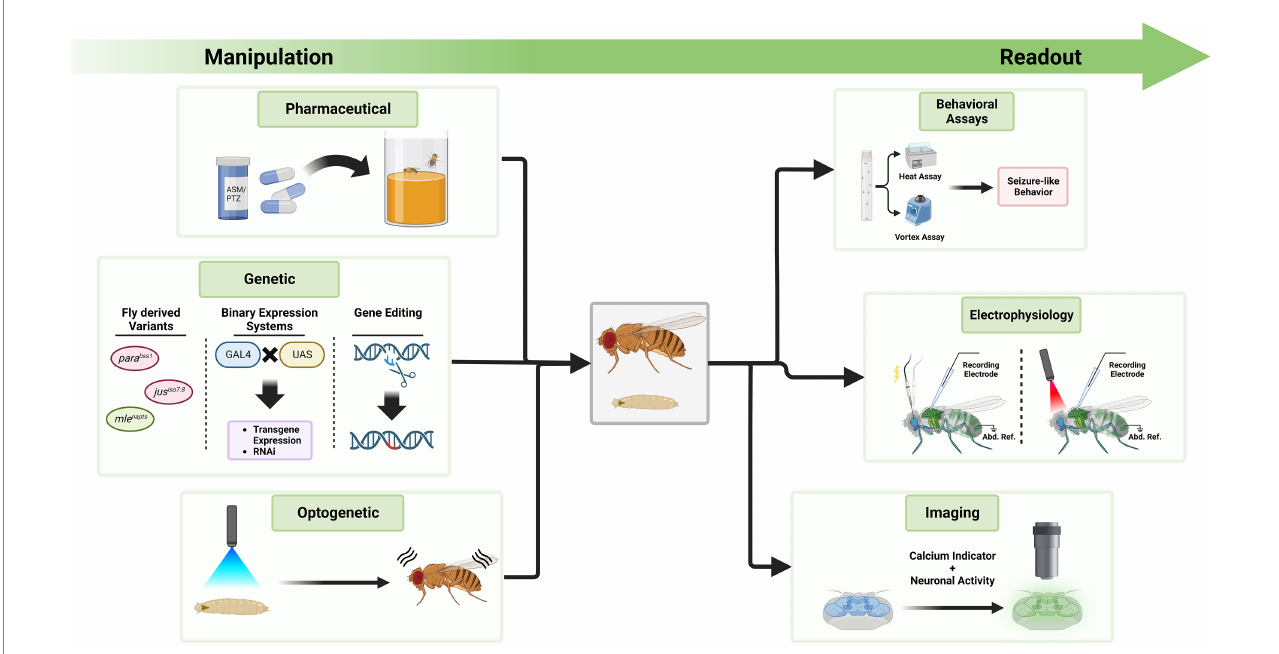
FIGURE 4 Exemplary tools to manipulate seizure-susceptibility in Drosophila and to assess a seizure-like phenotype. The Drosophila toolkit allows to manipulate seizure-susceptibility in flies and to assess their phenotype in relation to seizures. On the left side, different methods are displayed through which Drosophila can be manipulated. Feeding of compounds like ASMs or PTZ, genetic manipulation, or optogenetic manipulation can exacerbate or decrease seizure-susceptibility. Fly-derived variants increasing seizure-susceptibility are color coded in red, those decreasing it in green. To investigate the effect of these alterations, methods on the right side can be used. These include behavioral assays, electrophysiological measurements and imaging approaches. Seizure induction during electrophysiological measurements can be achieved via electrostimulation at the brain or light stimulation if neurons express channelrhodopsins. Activity is measured at the flight muscle with a reference electrode in the abdomen (Abd. Ref.). Techniques on either side can be utilized simultaneously, depending on the research question at